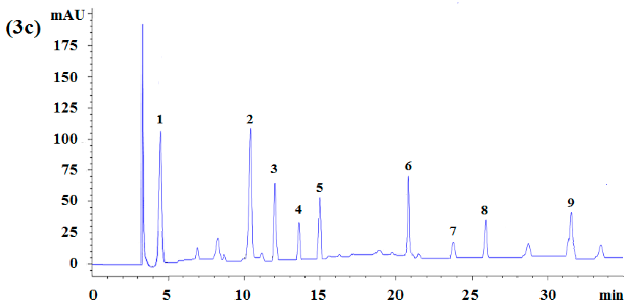
Figure 3. The representative chromatograms for blank ( a ), standards ( b ) and the typical chromatograms for the nine phenols in the sample of NO.5 ( c ). Peaklabels: 1. gallic acid, 2. catechin, 3. chlorogenic acid, 4. vanillic acid, 5. syringic acid, 6. cumaric acid, 7. ferulic acid, 8. rosemary acid, and 9. quercetin.